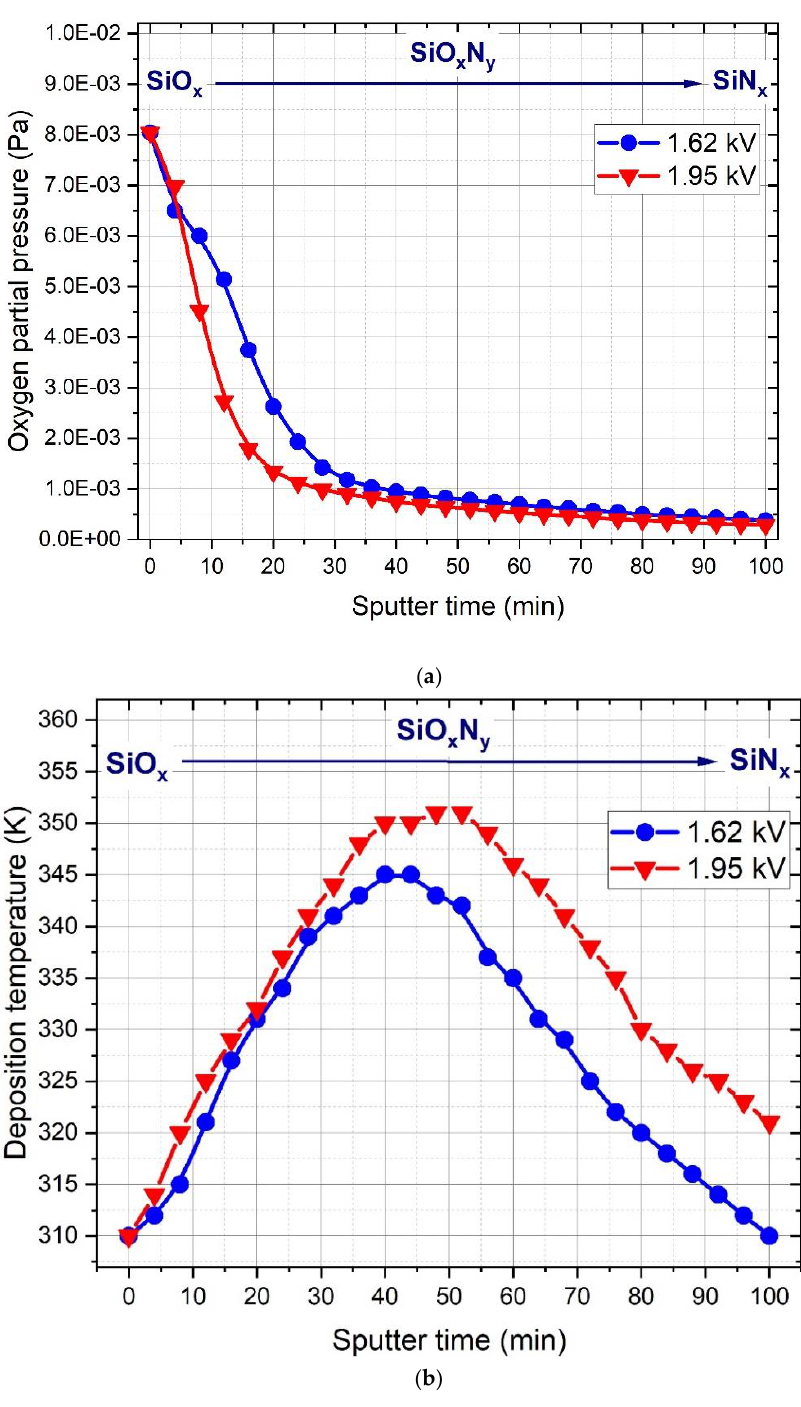
Figure 9. Fitting results of the ( a ) oxygen partial pressure and ( b ) deposition temperature defined in Equation (1) as a function of sputter